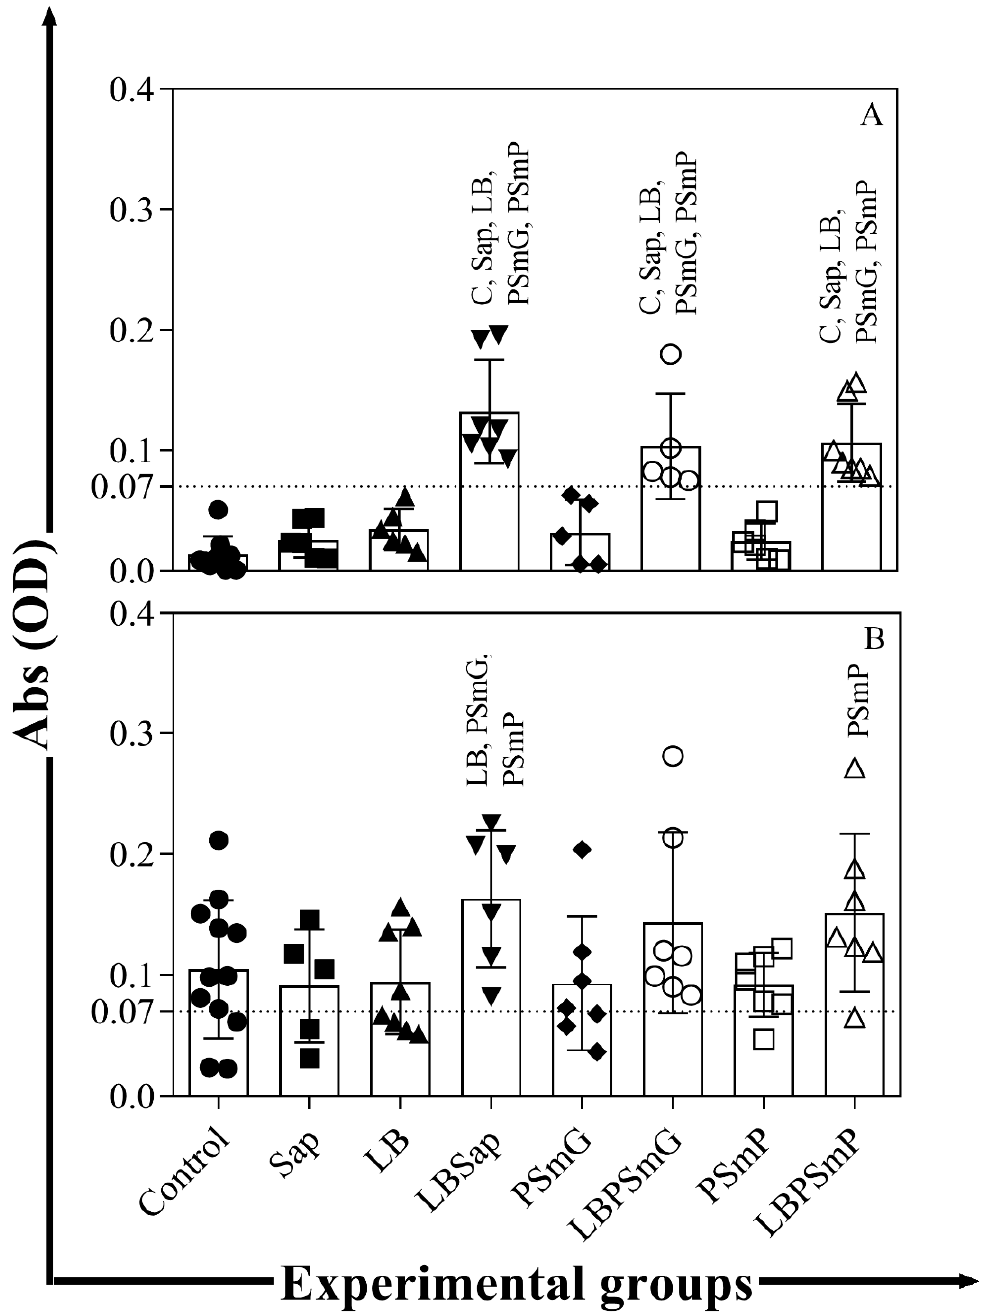
Figure 1. Evaluation of anti-Leishmania infantum humoral immune response in hamsters from the different experimental groups . Serum samples were obtained from the animals 30 days after the third dose of the vaccines ( A ) and 200 days after the experimental challenge ( B ). The graphs represent the mean values and standard deviations of total IgG optical density measured by the ELISA assay for each group. Statistical differences ( p < 0.05, Mann–Whitney) between groups are indicated by acronyms in the correlated group(s). LEGEND: C—Control (full circle); Sap—Saponin (full square); LB— L. braziliensis antigen (full triangle); LBSap— L. braziliensis antigen plus saponin (full inverted triangle); PSmG—Empty submicrometric large particle (full diamond); LBPSmG—Submicrometric large particle plus Leishmania braziliensis antigen (empty circle); PSmP—Empty submicrometric small particle (empty square); LBPSmP—Submicrometric small particle plus Leishmania braziliensis antigen (empty triangle).